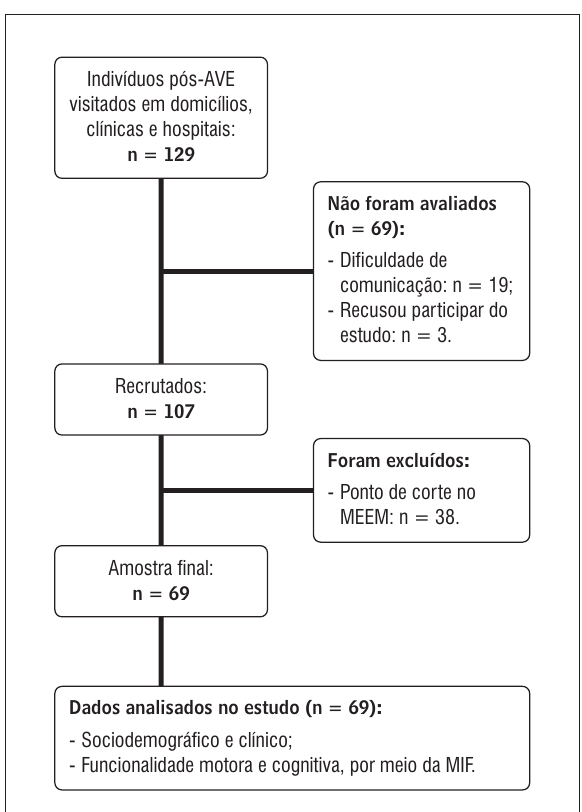
Figura 1 - Fluxograma de seleção da amostra, Recife-PE, 2010 Fonte: Dados da